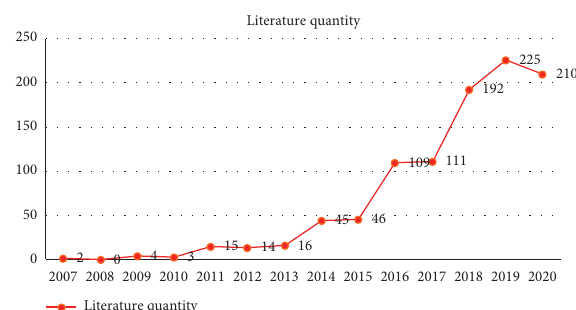
Figure 1: Annual distribution of the quantity of academic papers.